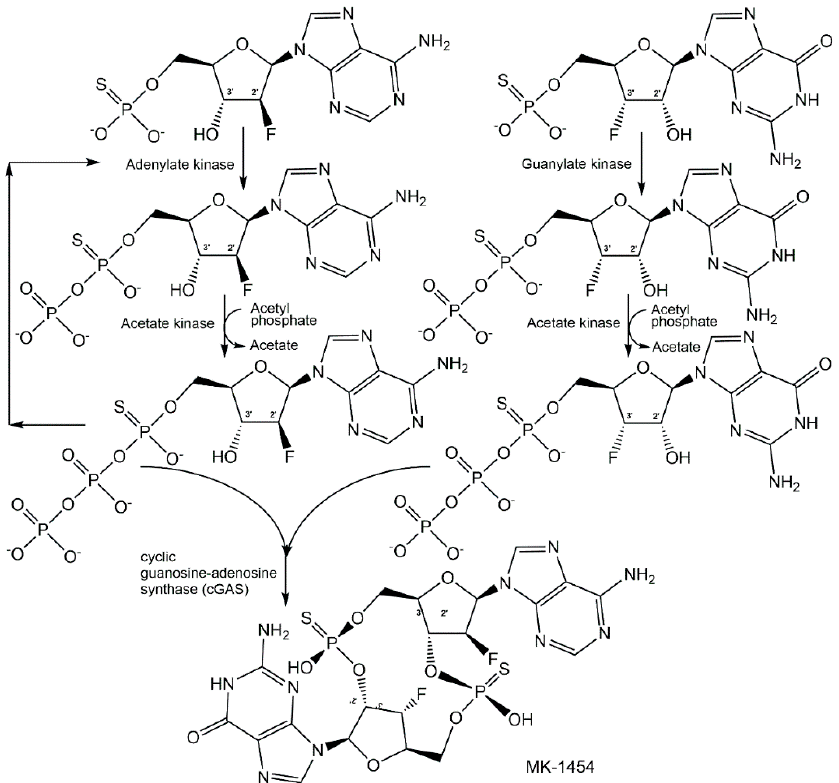
Figure 20. Biocatalytic synthesis of a single diastereomer of the non-natural cyclic dinucleotide MK-1454 with the desired stereochemistry of the R p / R p phosphorothioate linkage.